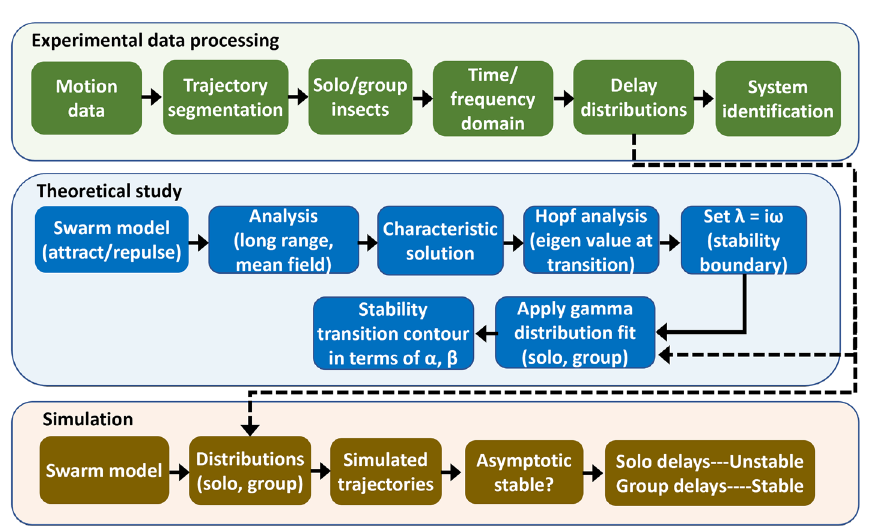
Figure 10. Overall study incorporates three components: a multi agent tracking experiment, theoretical analysis, and simulated